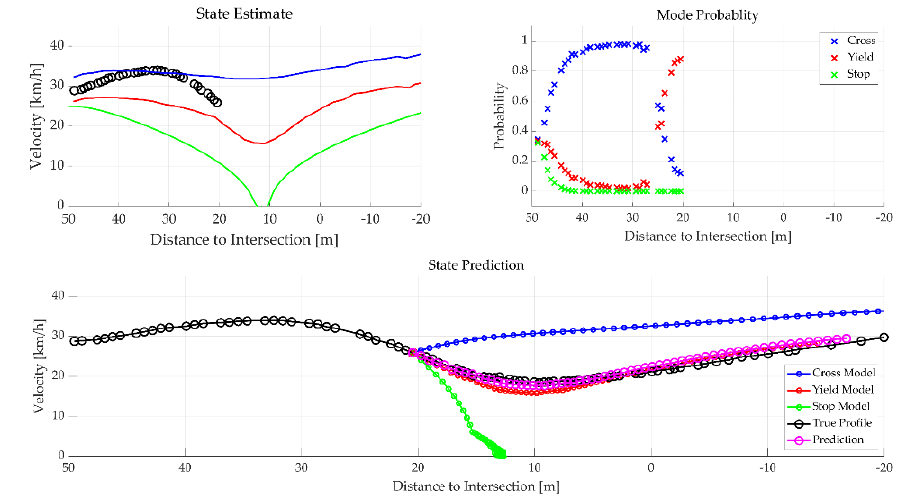
Figure 7. Target state prediction results.